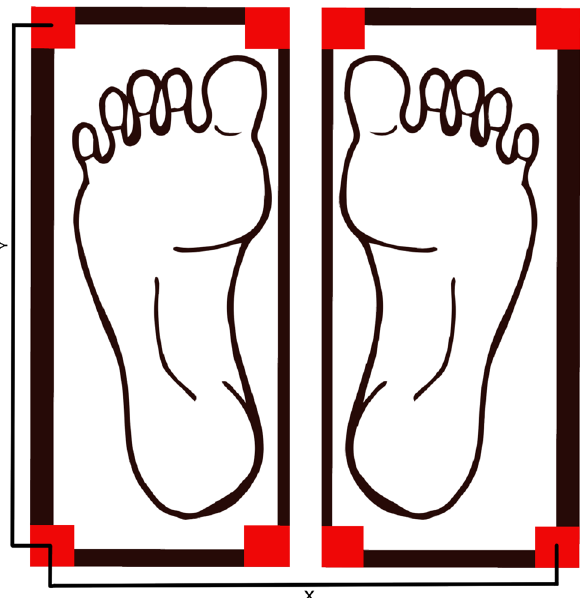
Figure 8. This figure shows the position of the feet as they are placed on the force platform during the experiment. The anterior–posterior displacement is calculated using the formula: AP - Displacement ( cm ) = Y ( cm ) ∗ StaticVR_AP/2 . Where StaticVR AP is the percentage of the vertical size of the board between −1 and 1. The medio-lateral displacement is calculated using the formula: ML_Displacement ( cm ) = X ( cm ) ∗ StaticVR_ML / 2 Where StaticVR ML is the percentage of the horizontal size of the board between −1 and